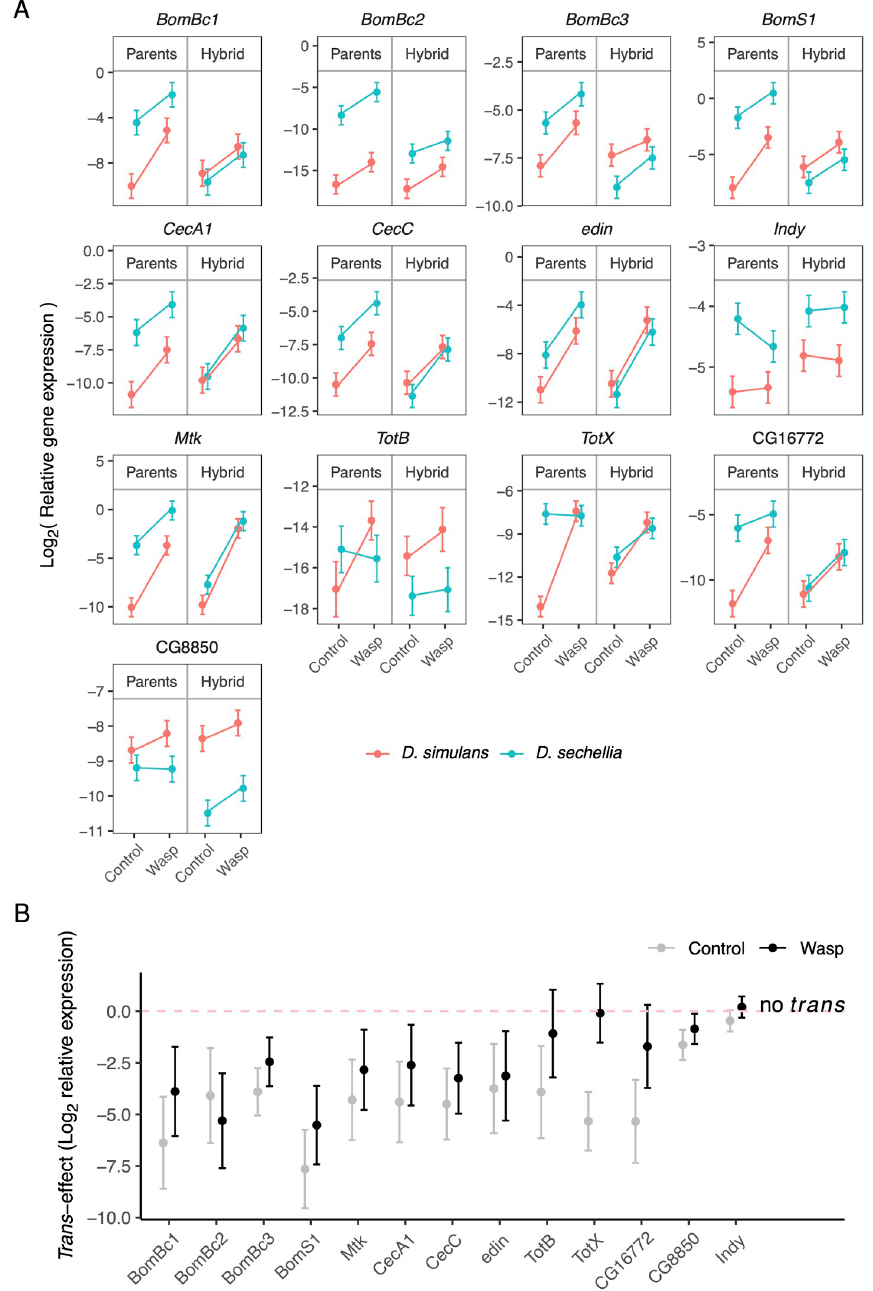
Fig 7. Relative expression between D. simulans and D. sechellia alleles and Trans regulatory divergence in humoral immunity genes. Relative gene expressions were quantified by qPCR in parental and F1 hybrid larvae. The relative allelic expression in hybrids were estimated using proportions inferred from Illumina MiSeq sequencing of hybrid transcriptions for each gene, and the relative allelic expression between parental larvae were calibrated to half accordingly. (A) Relative allelic expressions between parental larvae and F1 hybrids under unchallenged (control), and infected (immune challenge imposed by injections of wasp homogenate) conditions. (B) Trans- regulatory divergence between D. simulans and D. sechellia in unchallenged and infected larvae, measured as the log 2 ratio of relative D. simulans over D. sechellia expression. Error bars are 95% confidence intervals on model coefficient.